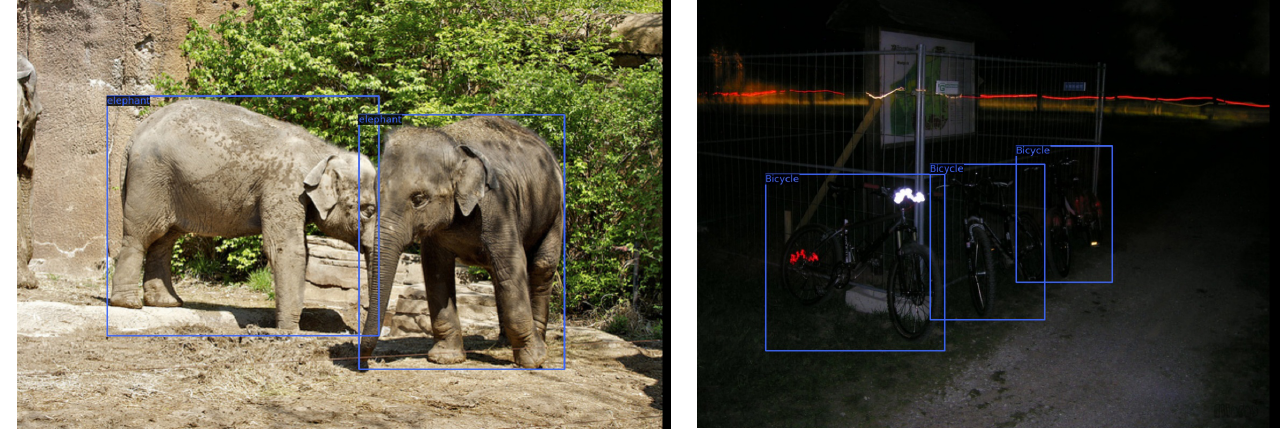
Figure 1. Visual illustration of the difference between object detection in a generic and challenging environment. ( a ) A sample image taken from the COCO dataset [12], whereas ( b ) is taken from the ExDark dataset [13]. The blue color represents ground truth annotation.